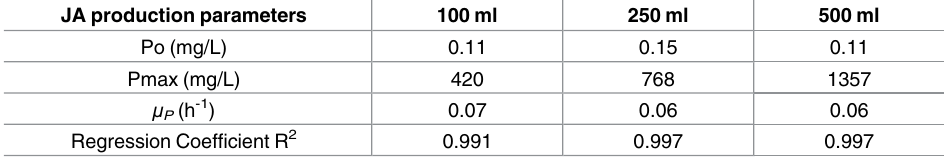
Table 3. Parameters defining the logistic model of JA-production. L . theobromae strain 2334 was culti- vated in shake flasks of 100 mL, 250 mL and 500 mL in the presenceof KNO 3 as nitrogensource. JA production parameters